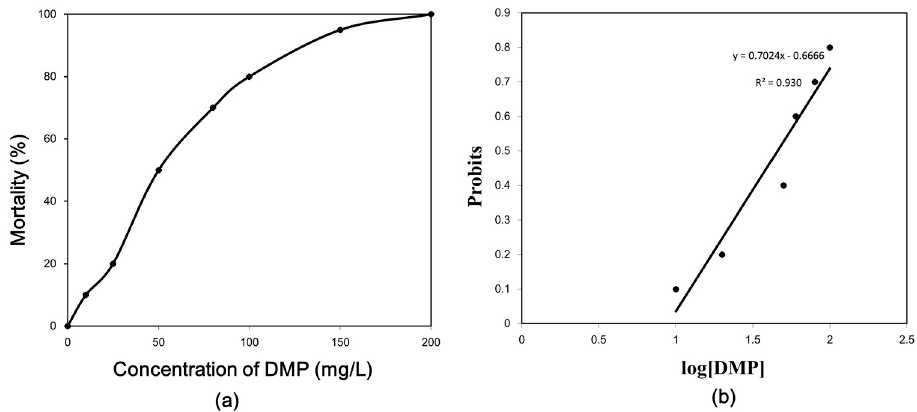
Figure 1. Dose–response relationships after 96 h of exposure for dimethyl phthalate (DMP): ( a ) mortality of zebrafish treated with different concentrations of DMP; ( b ) probit models at different concentrations of DMP for calculation of the LC 50 .